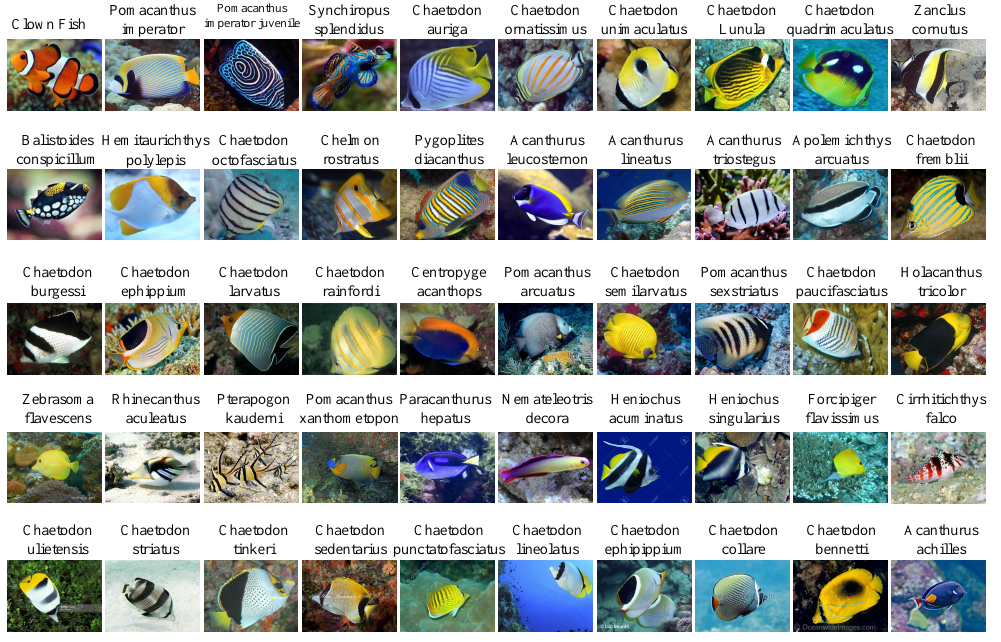
Figure 5. All the representative images of reef fish species from our novel ReefFish dataset.